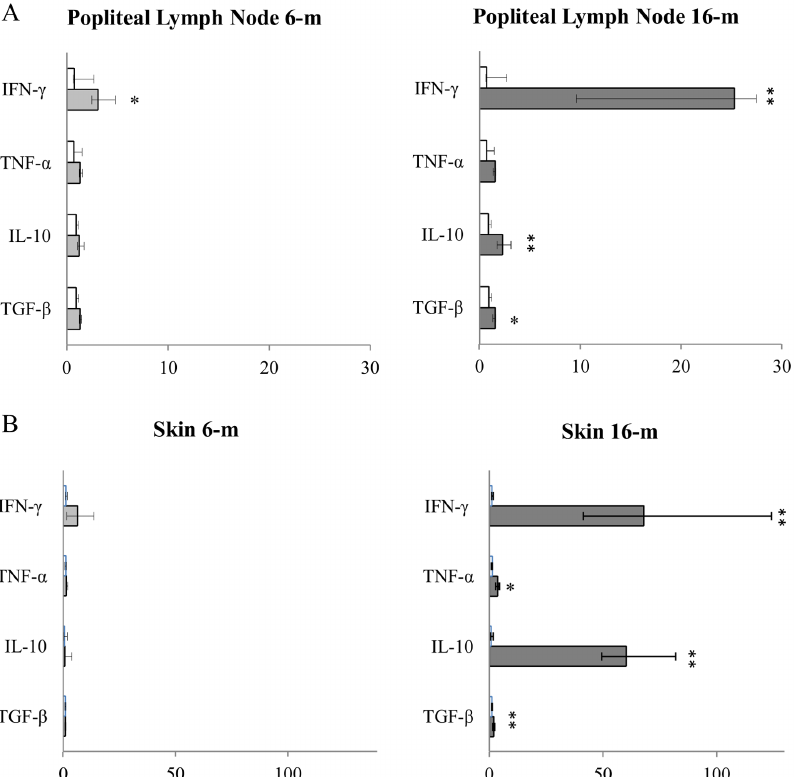
Fig 3. Median cytokine expression in (A) popliteal lymph node and (B) healthy pinna skin samples throughout the course of L.infantum experimental infection. Y-axis: cytokine; x-axis: fold-increase of cytokine expression according to the 2 − ΔΔ Ct method using the mean value of the Δ C of the Non-infected dogs (NID) group as calibrator. White bars: NID; Bright-grey bars: dogs after 6 months (6-m) of L . infantum experimental infection; Dark-grey bars: dogs after 16 months (16-m) of L . infantum experimental infection. Significant differences in median cytokine levels among groups are indicated by * P < 0.05, ** P < 0.01, *** P < 0.001.